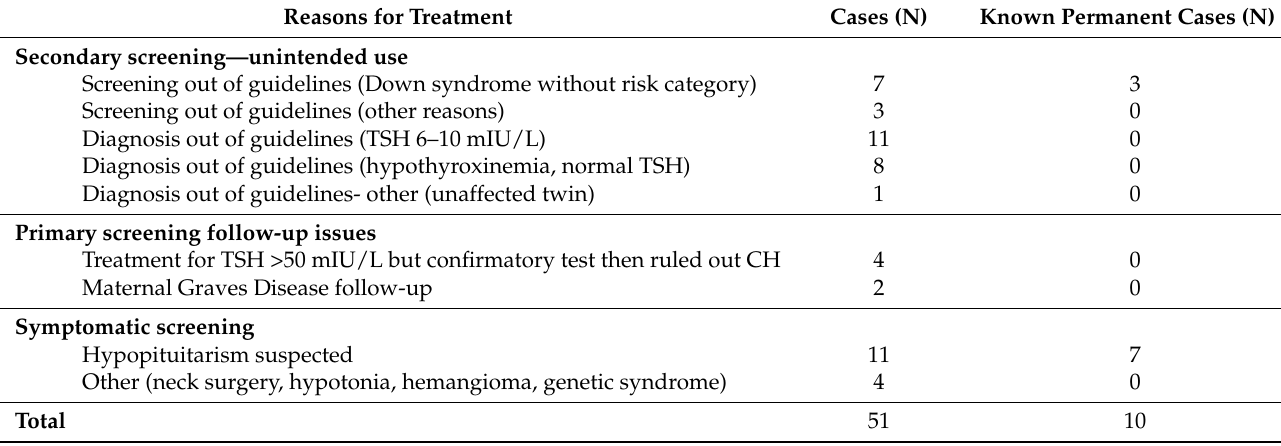
Table 5. Presumed congenital hypothyroidism cases treated with levothyroxine in the first 60 days of life due to testing or judgement outside of the defined screening process.